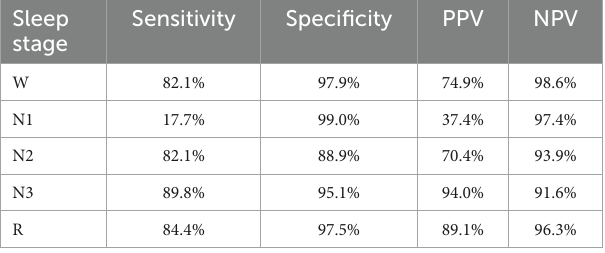
TABLE 3 Detailed stage-wise classification performance metrics in the test set aggregated across the 10-fold cross-validation in the primary analysis set ( n = 105).